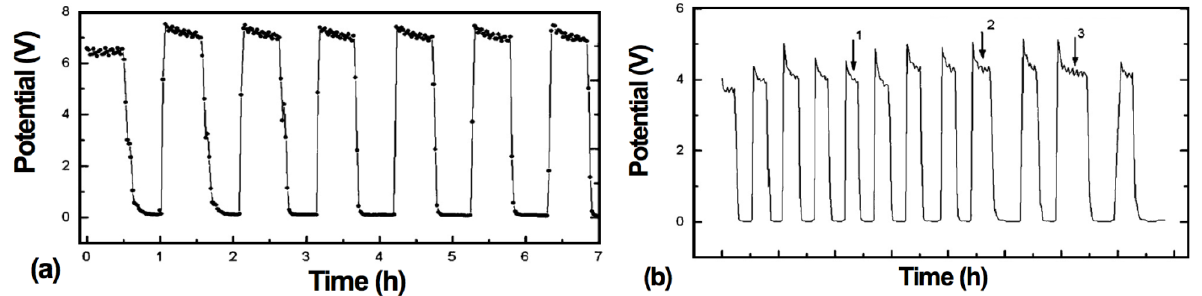
La TiO supported-cell with 0.8 0.2 3 for 45 min and air 2